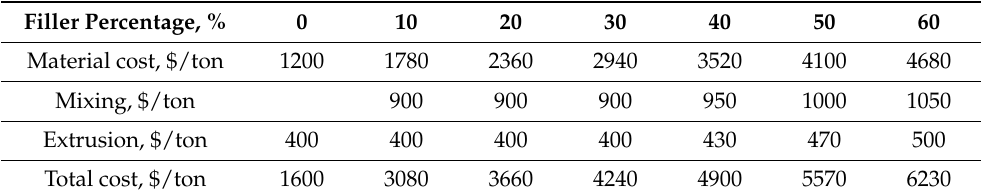
Figure 7. ( a ) Overall heat-transfer coefficient, ( b ) required heat-transfer area, ( c ) required material volume, and ( d ) required material weight for Ti, polymer-composite (60–40), and polymer-composite (70–30) MED evaporator. Table 4. The cost of the tubes fabricated using different filler